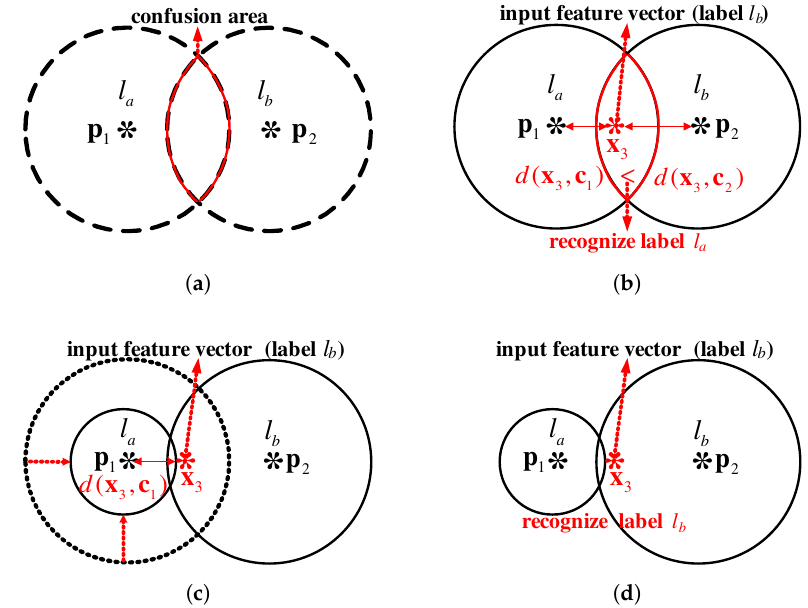
Figure 1. Learning and recognition process of traditional (TR)-restricted coulomb energy (RCE) and dynamic decay adjustment (DDA)-RCE. ( a ) Example of TR-RCE learning for two feature vectors x 1 and x 2 , ( b ) recognition result for the feature vector x 3 after TR-RCE learning, ( c ) example of DDA-RCE learning for three feature vectors x 1 , x 2 , and x 3 , ( d ) recognition result for the feature vector x 3 after DDA-RCE